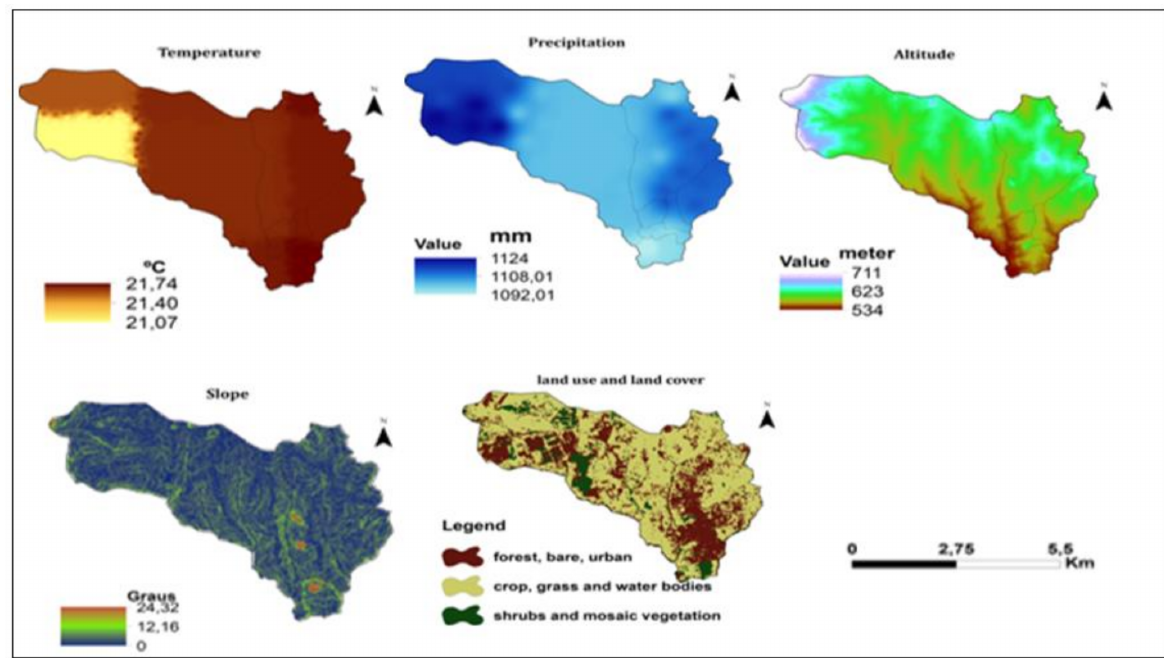
Figure 6. Presents the map of average temperature, precipitation, altitude, slope, and land in Sussundenga Village.